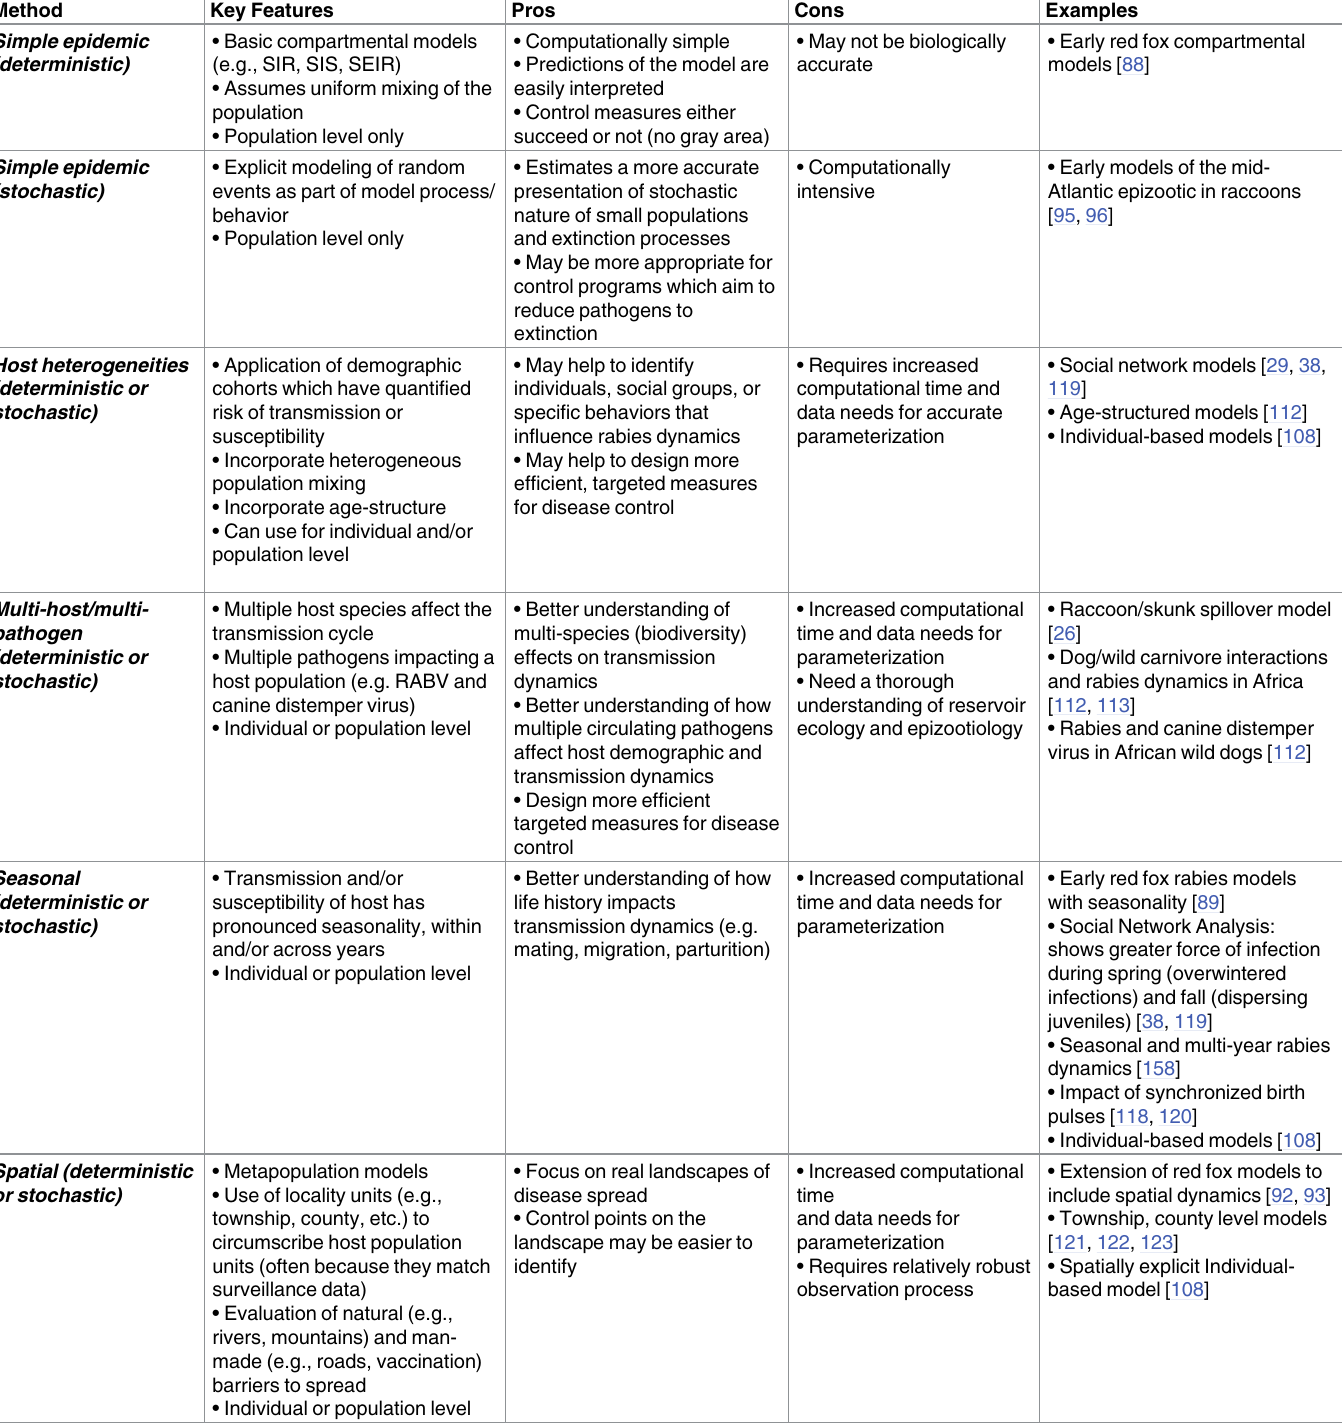
Table 2. Summaryof modeling approaches used to understand rabies dynamics in wildlife, conceptually structured as in Keeling and Rohani [90].